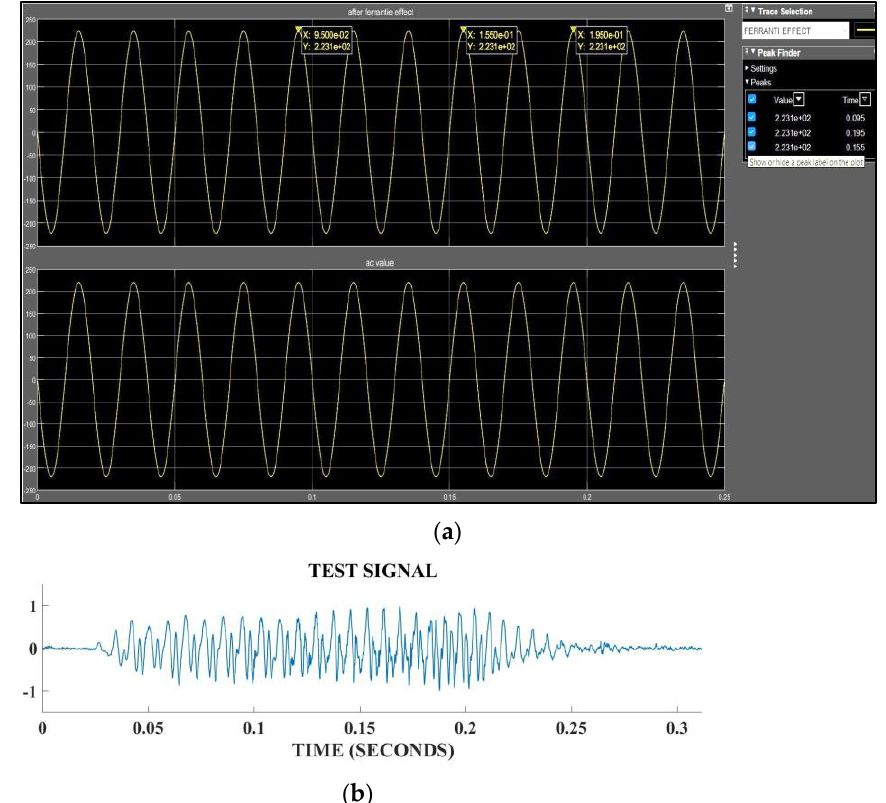
Figure 18. ( a ) Simulated Ferranti Effect ( b ) Zoom view of the captured signal during CCHIF along with Ferranti effect.